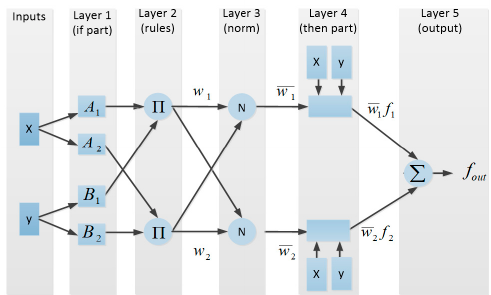
Figure 1. Overall configuration of the adaptive neuro-fuzzy inference system (ANFIS).